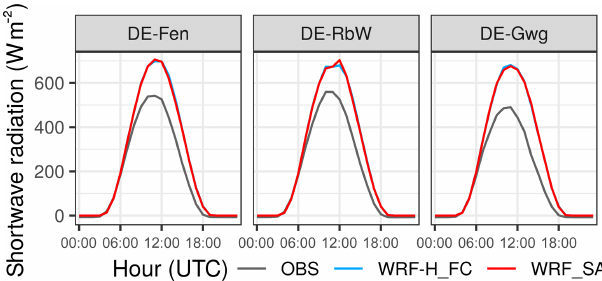
Figure 7. Mean diurnal cycles of simulated and observed downward longwave radiation for June to October